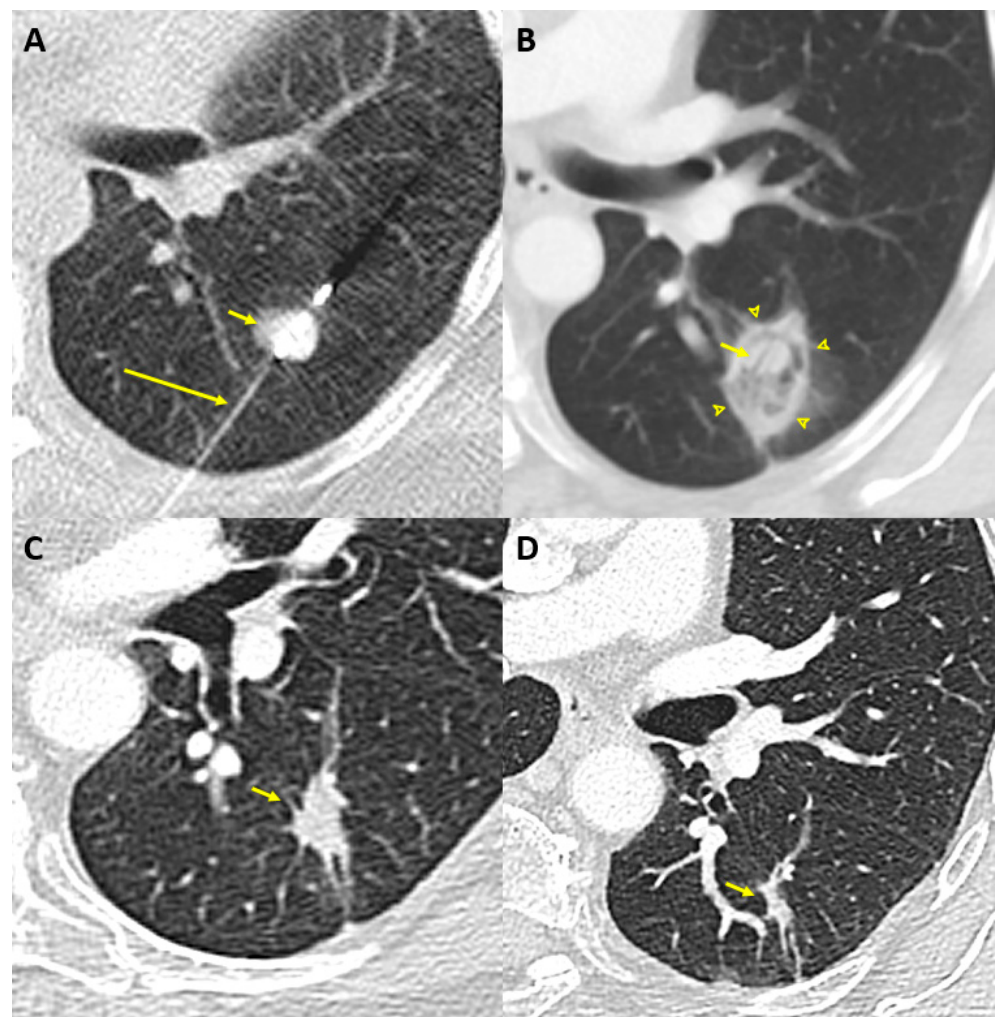
Figure 1. Example of MWA in a sixty-year-old woman with a 13 mm nodule in the apical segment of the left lower lobe. ( A ) Axial non-contrast chest computed tomography scan obtained during the MWA procedure shows the MWA probe (long arrow) placed percutaneously in the nodule (short arrow). ( B ) The computed tomography scan performed 6